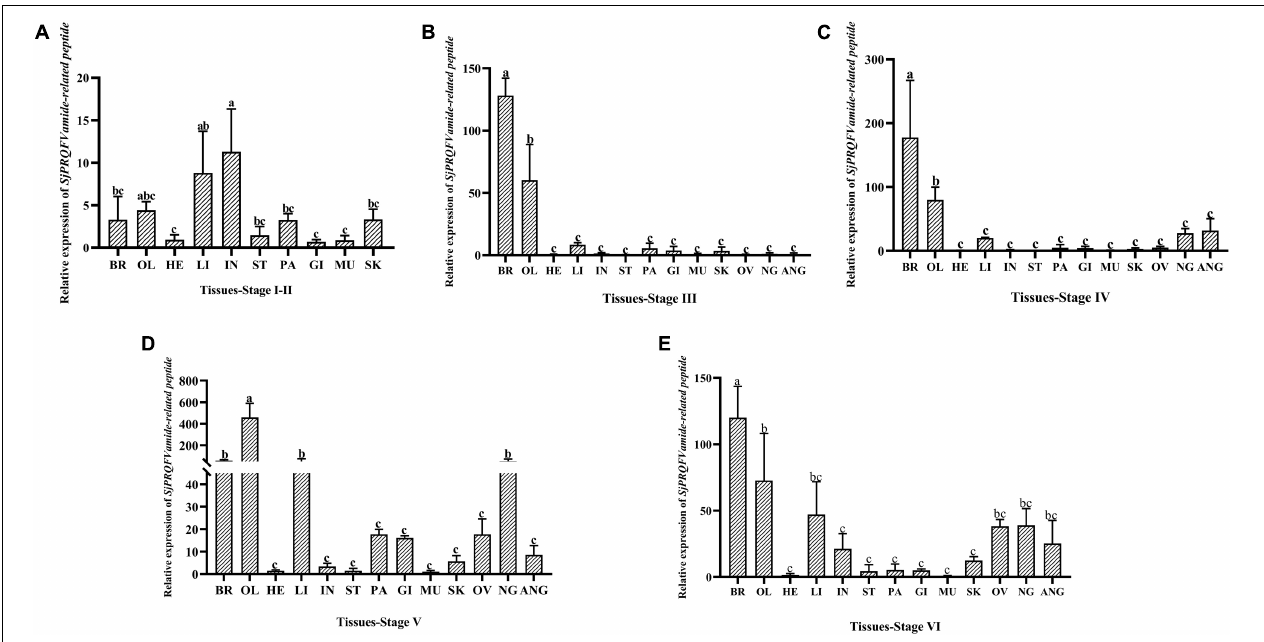
FIGURE 4 | Expression analysis of SjPRQFVRP from diverse tissues at different development stages of female cuttlefish. (A) Stage I-II; (B) stage III; (C) stage IV; (D) stage V; (E) stage VI. In each case, the transcripts of the muscle were served as the reference value. Vertical bars represent the mean ± SD ( n = 3). The analyses were conducted in tissues including the brain (BR), optic lobe (OL), heart (HE), liver (LI), intestine (IN), stomach (ST), pancreas (PA), gill (GI), muscle (MU), skin (SK), ovary (OV), nidamental gland (NG), and accessory nidamental gland (ANG). GAPDH and β -actin served as reference genes. Different letters on the bars indicate statistically significant differences ( p <